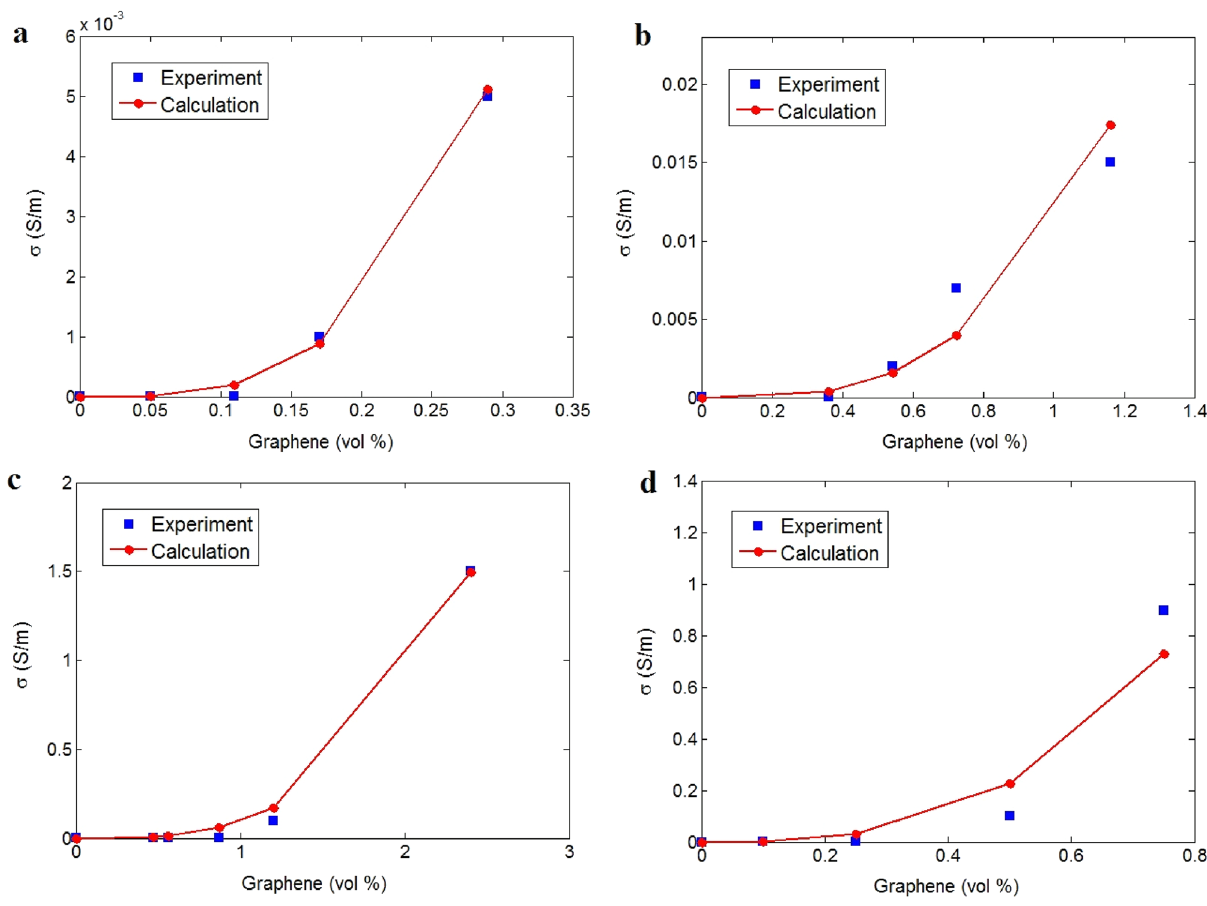
Figure 2. Tested conductivity and forecasts for ( a ) PI 54 , ( b ) PVA 55 , ( c ) PET 64 , and ( d ) PS 56 graphene